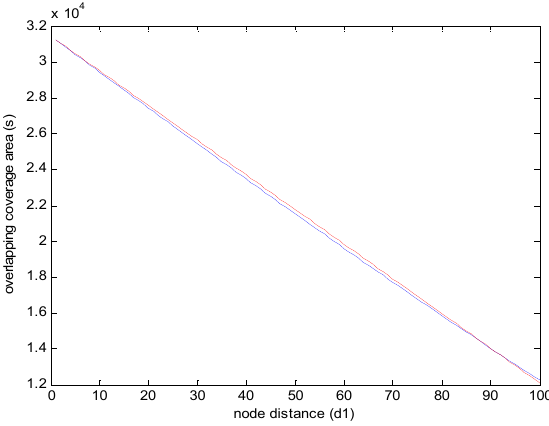
Figure 7. The evaluation error between s and f.